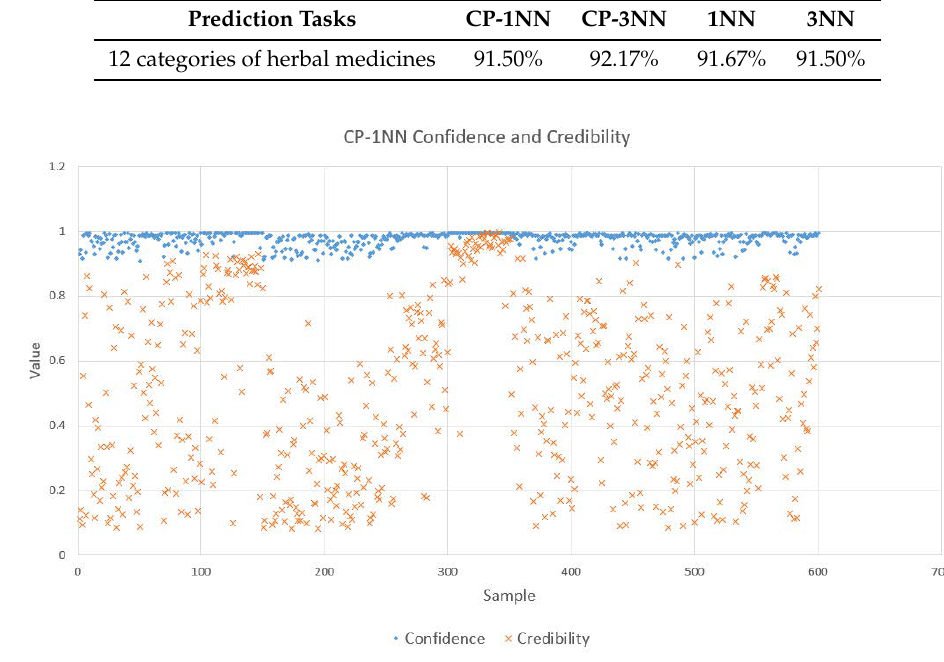
Table 6. Conformal prediction accuracy in offline mode.